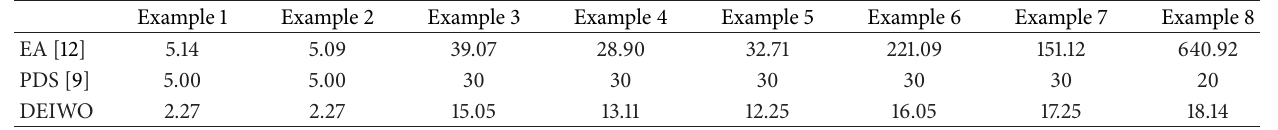
Table 12: Comparison of results for CPU time required by the DEIWO for all the examples.